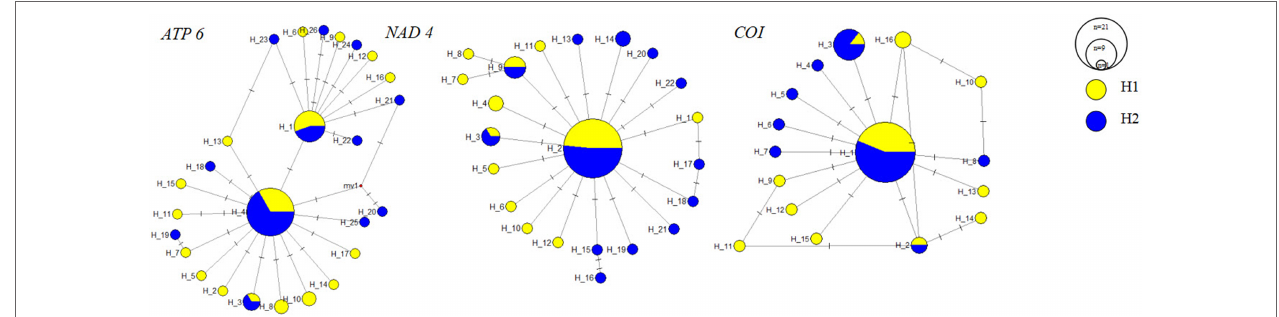
FIGURE 4 | Statistical parsimony network for haplotypes from G. haimaensis samples collected at Haima cold seep. Large circles represent a single individual. H1 represented by yellow circles. H2 represented by blue circles.